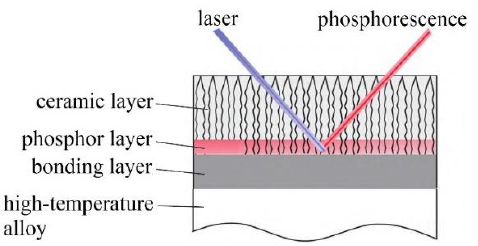
Figure 30. Schematic diagram of sensor TBC with phosphorescence coating [162]. Reprinted with permission from [162]. Aeronautical Manufacturing Technology, 2022.